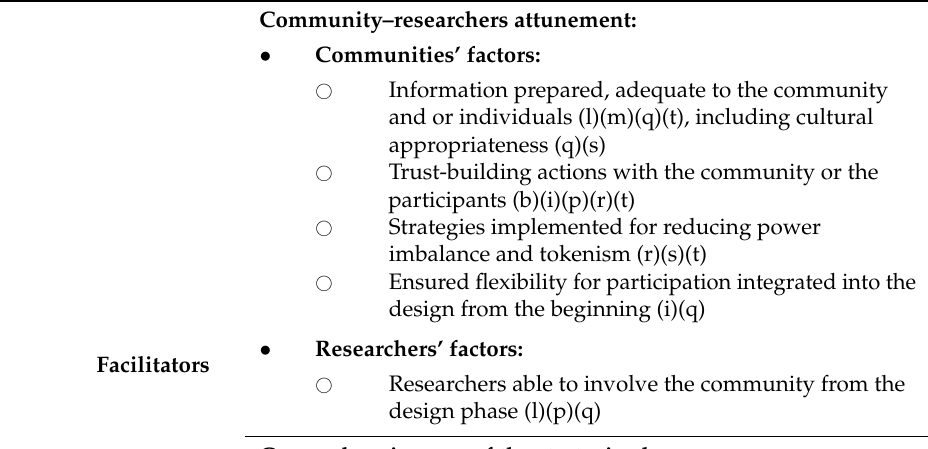
Table 4. Facilitators and barriers during design and